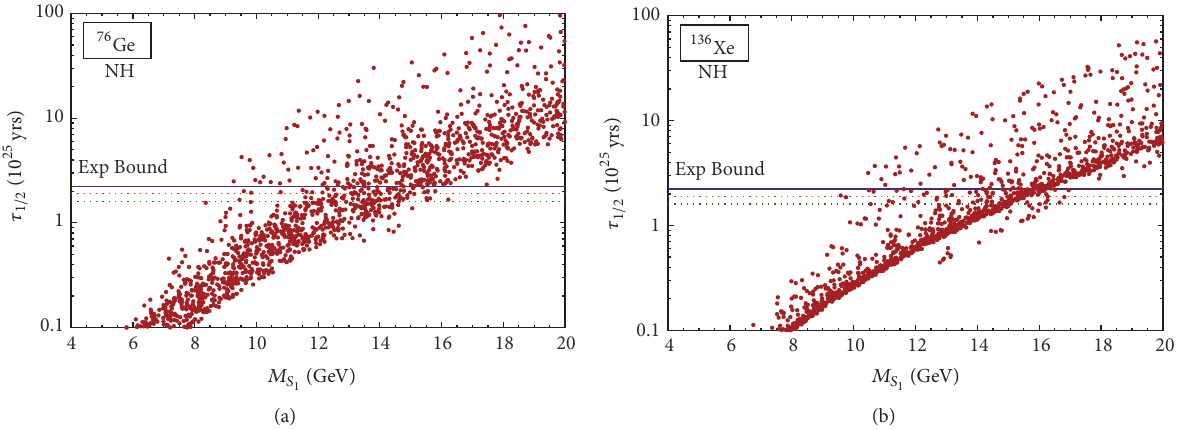
Figure 4: Scattered plots for half-life prediction of double beta decay as a function of neutral singlet fermion mass in the case of normal hierarchy (NH) of light neutrino masses from 76 Ge nucleus (a) and from 136 Xe nucleus (b).